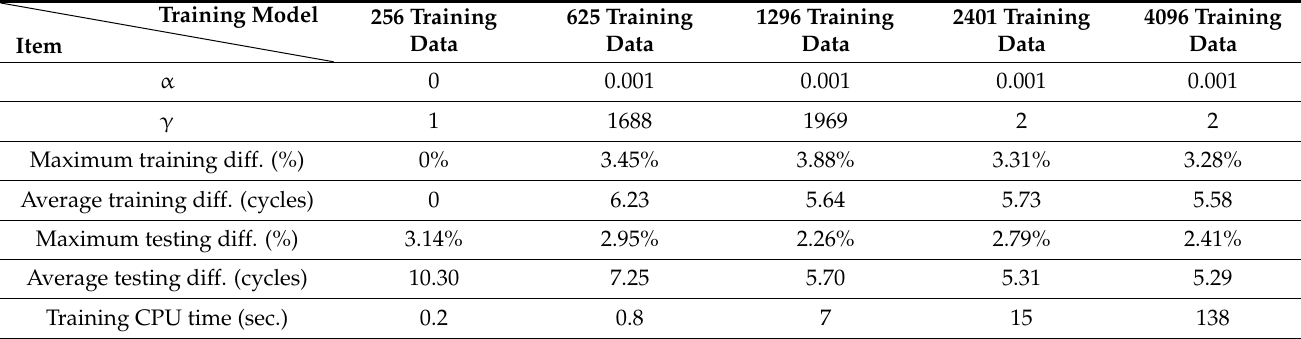
Table 12. The performance of the KRR